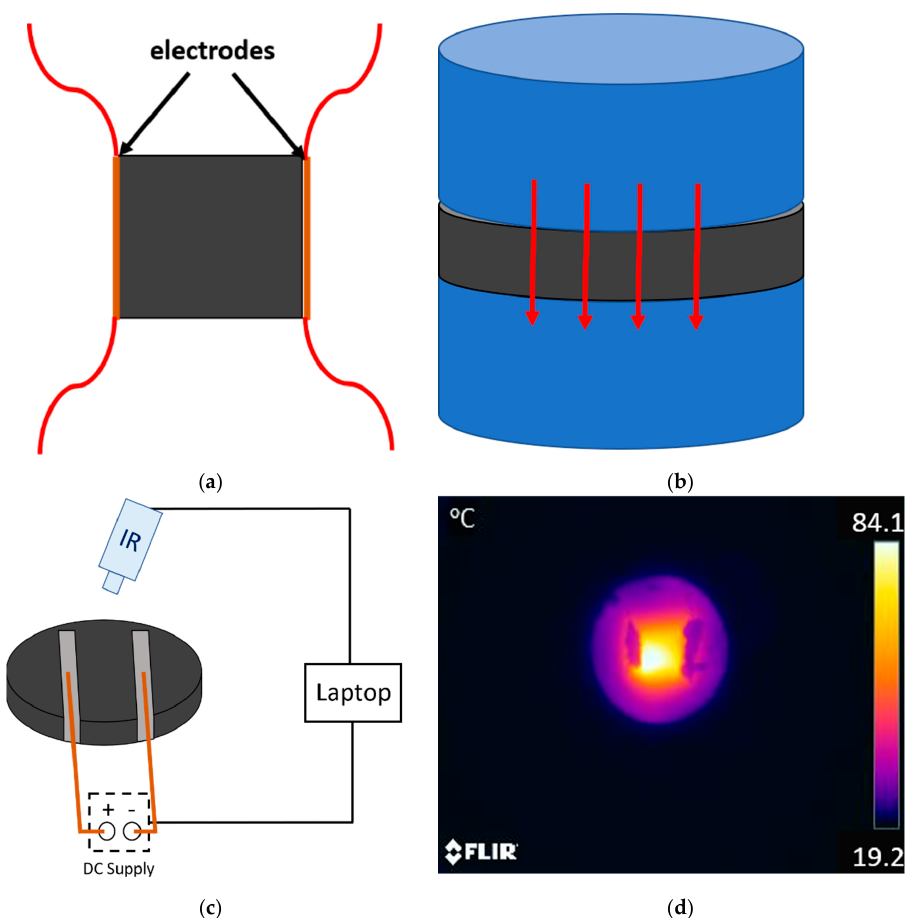
Figure 1. Schematics of ( a ) electrode disposition on the electrical conductivity tests, ( b ) set-up of thermal conductivity measurements (where the red arrows indicate the sense of the heat flow), ( c ) Joule heating tests indicating the electrode’s disposition in the sample and ( d ) an example of thermal image of a 5GNP-1 h sample (the dark shapes around the central region correspond to the silver paint coating of the